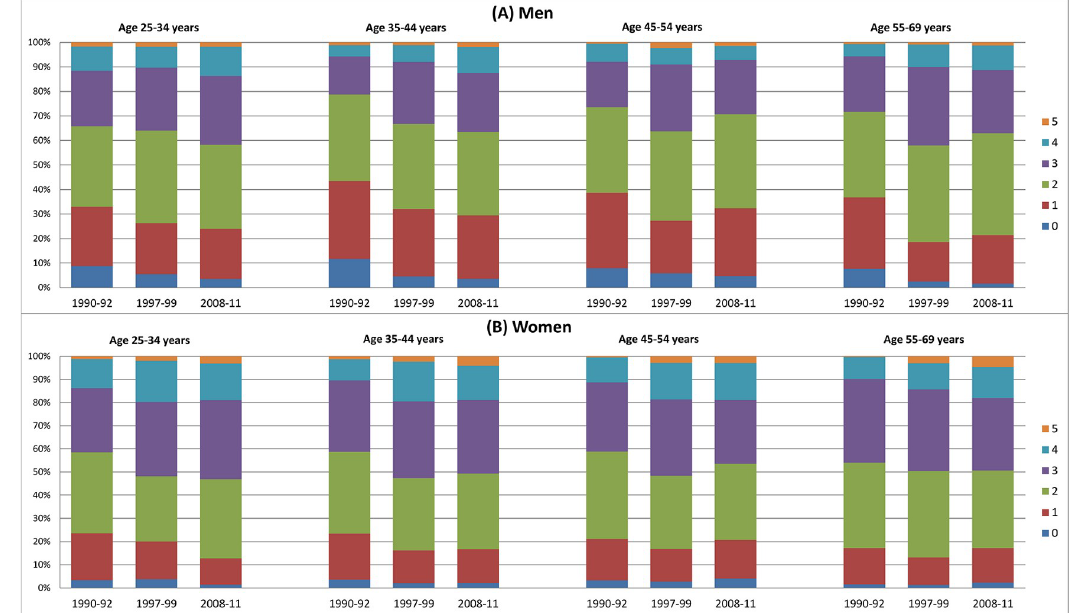
Fig 3. Proportions of specific numbers of healthy behavior factors among men (A) and women (B) by age groups.